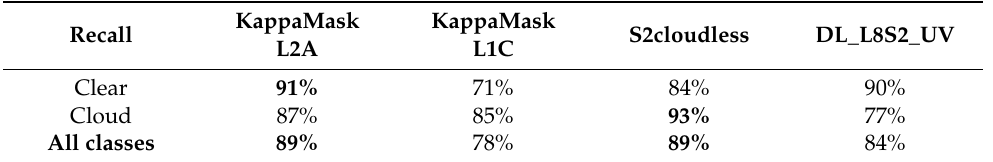
Table 8. Dice coefficient evaluation performed on the test dataset for KappaMask Level-2A, Kappa- clear, cloud shadow, semi-transparent and cloud classes.